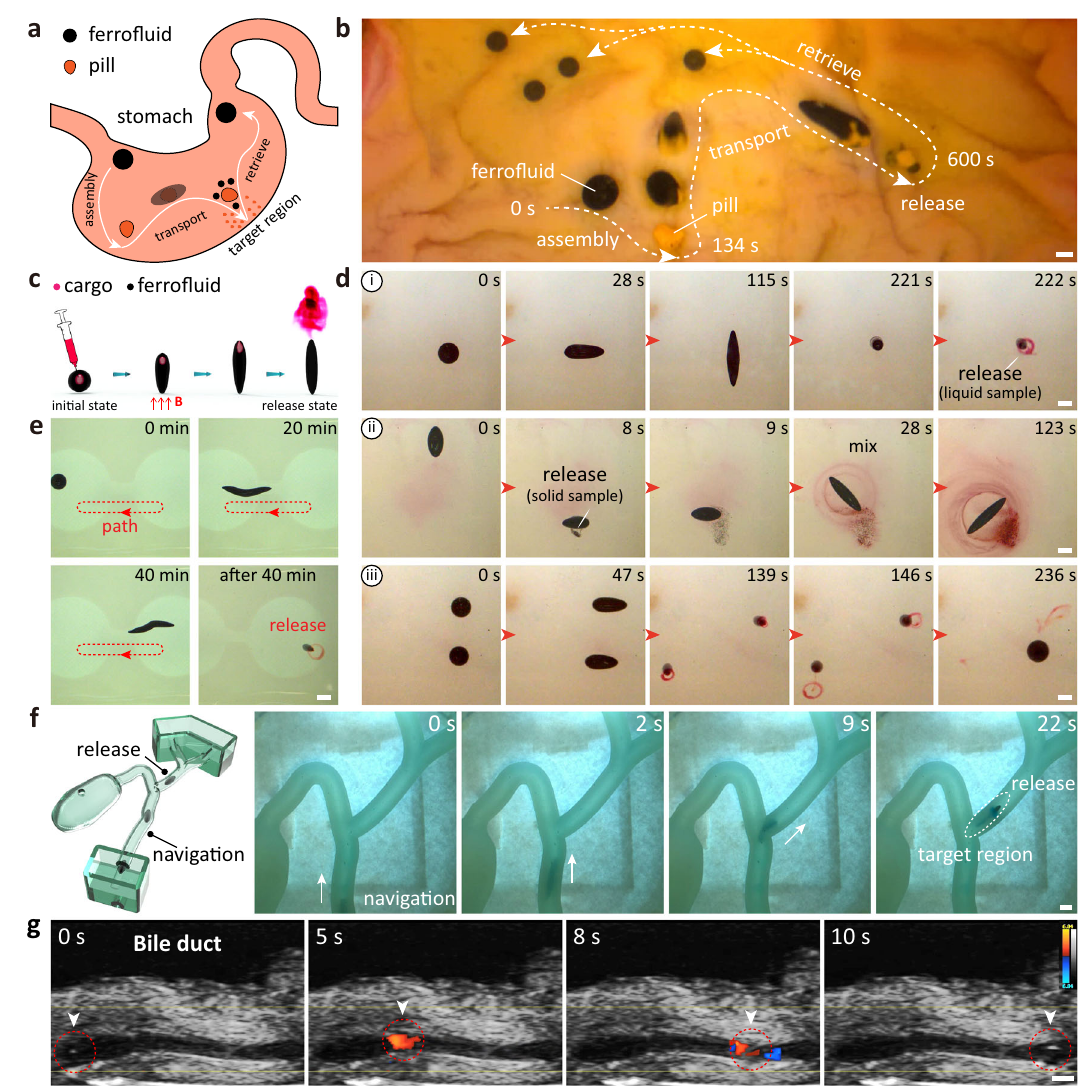
Fig. 5 | Controllable liquid capsule for on-demand cargo delivery. a Schematic diagram showing a ferro fl uid droplet transforming a traditional pill into an active drug delivery system. b The active construction, controlled locomotion and on- demand release of a liquid capsule in an ex vivo animal stomach. c Schematic diagram of a liquid capsule that ejects its internal cargo on demand by applying a magnetic fi eld. d